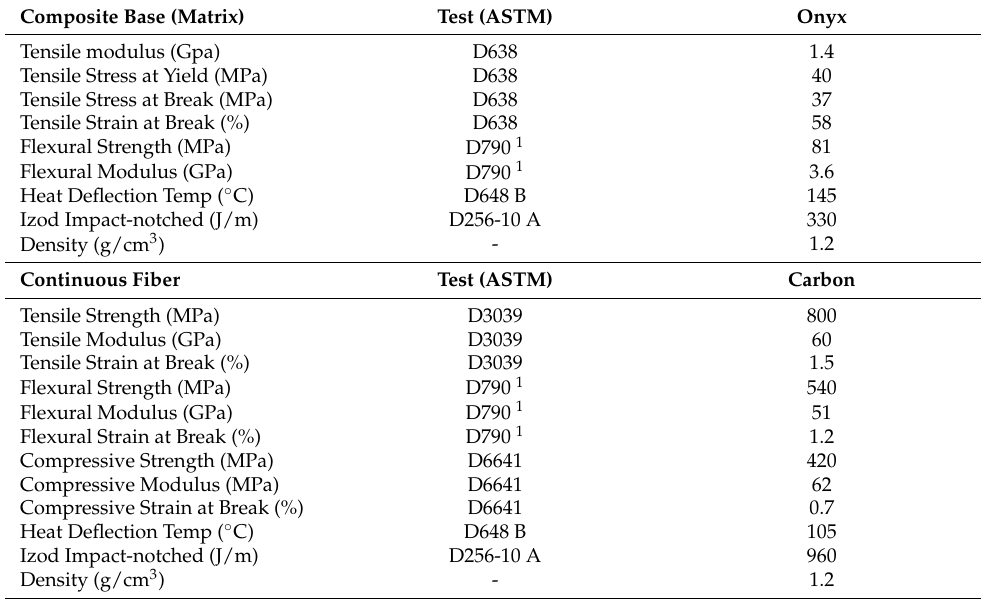
Figure 2. Layout of matrix and reinforcement for 3D printing of CFRP profiles. Onyx is a thermoplastic that is up to 1.4× stronger than ABS. The strength of the onyx can be further increased by reinforcement in the form of continuous fibers. Onyx is chemically prevent deterioration [44]. Onyx fibers with a diameter of 1.75 mm and carbon fibers with a diameter of 0.34–0.38 mm were supplied by Markforged. The mechanical properties (from datasheet) of the material used (onyx/CF) for 3D printing are given in Table 1. Table 1. Mechanical properties of materials for CF/onyx profiles